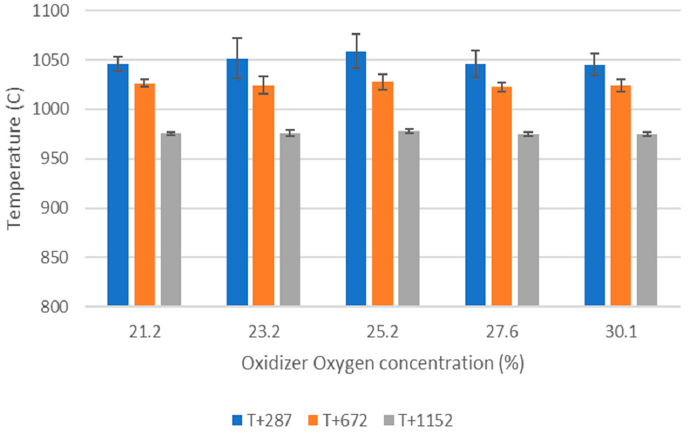
Figure 3. Temperatures at different O 2 input concentrations, O 2 /N 2 input mixes, total oxidizer flow rate in: 160 NL/min (except 30.1 case, 150 NL/min). “T+number” indicates the location of the thermocouple above the grate in mm (see also Figure 1).